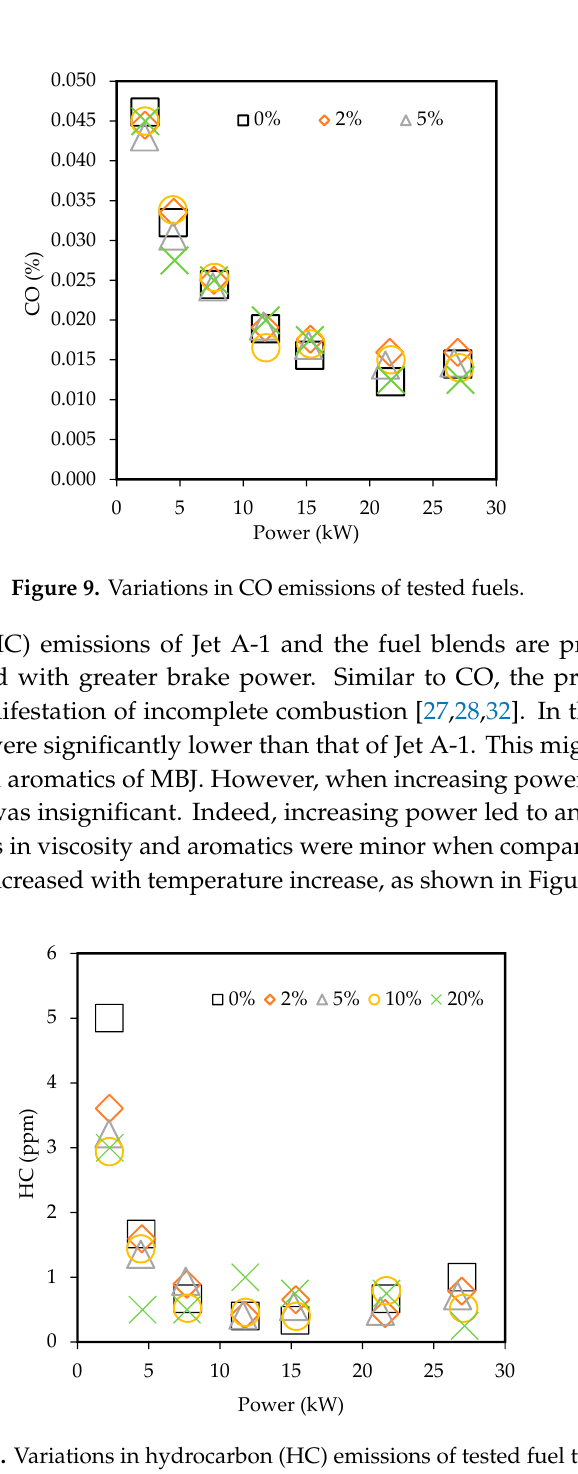
Figure 10. Variations in hydrocarbon (HC) emissions of tested fuel types.